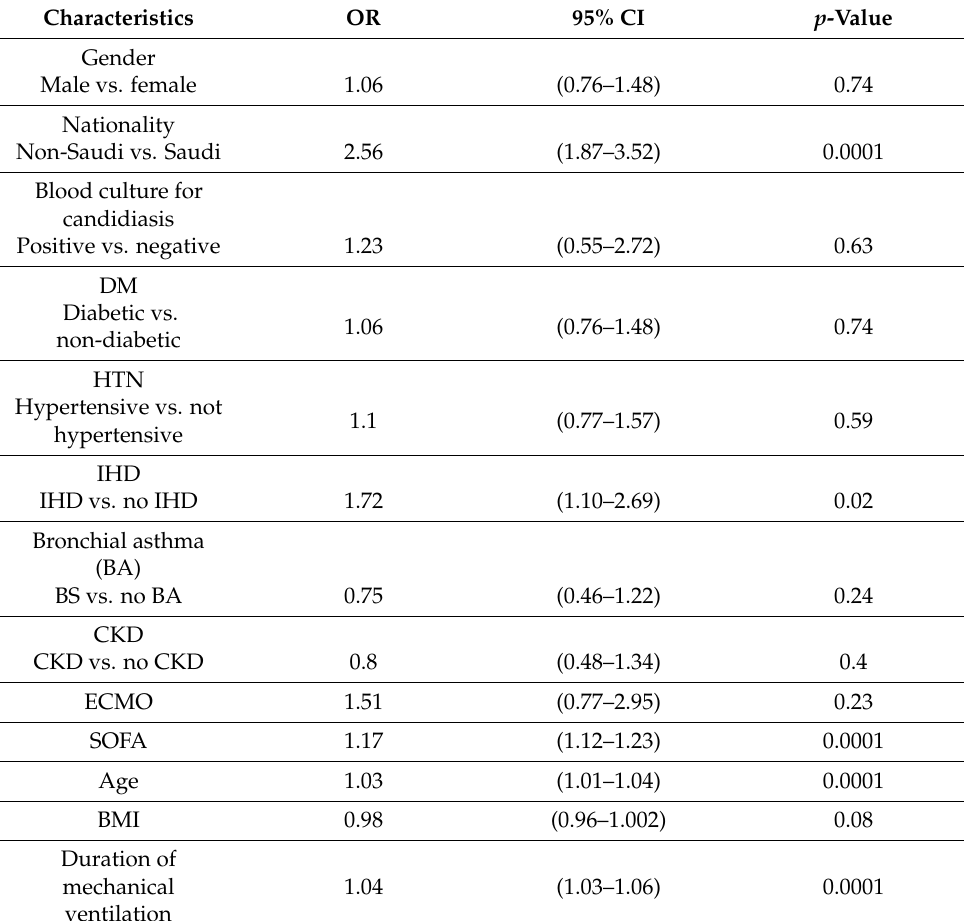
Table 3. Multiple logistic regression ( n = 1470).